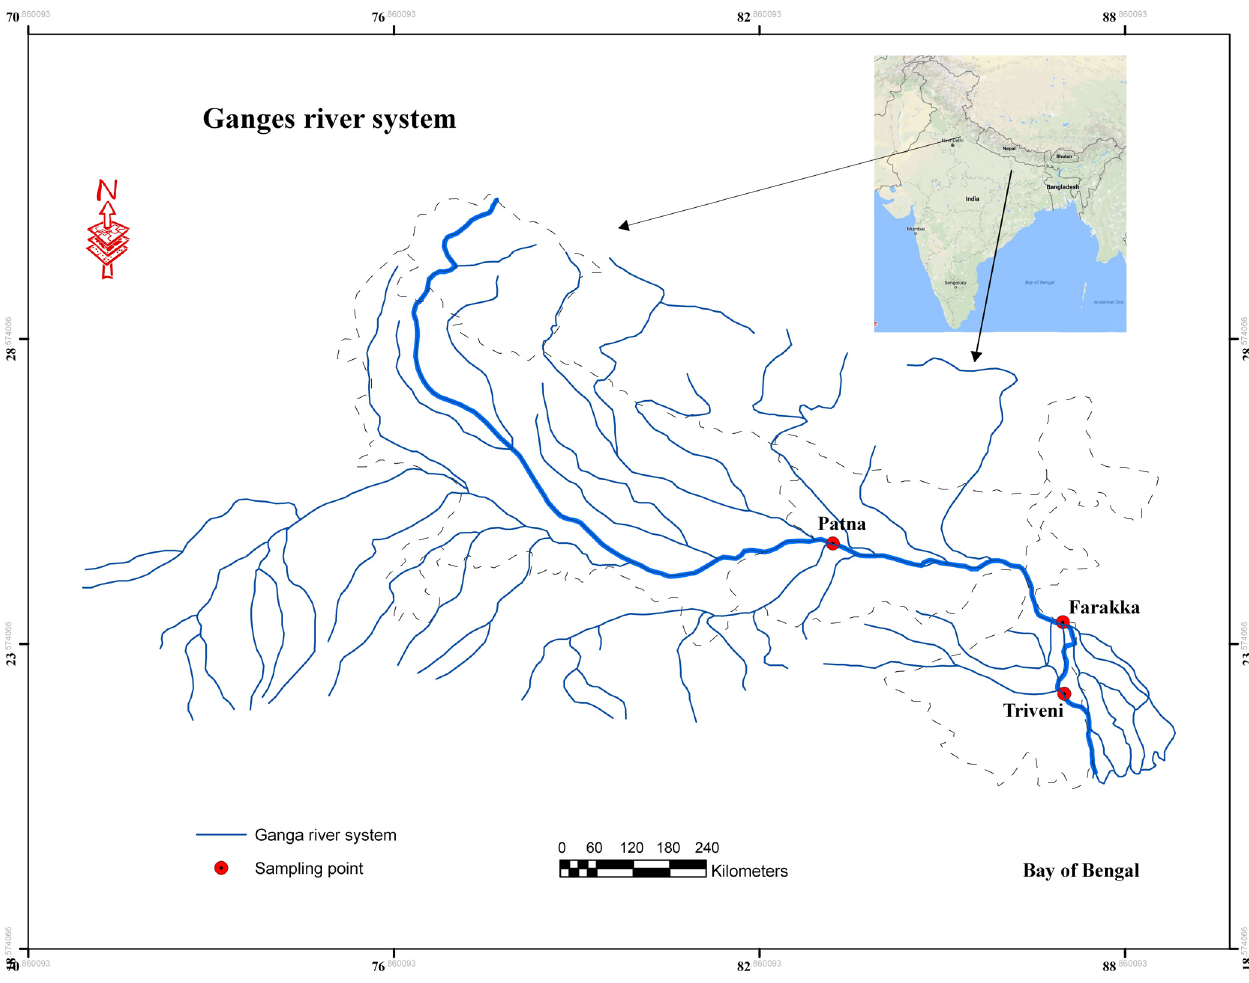
Fig. 1. Map showing areas of study along river